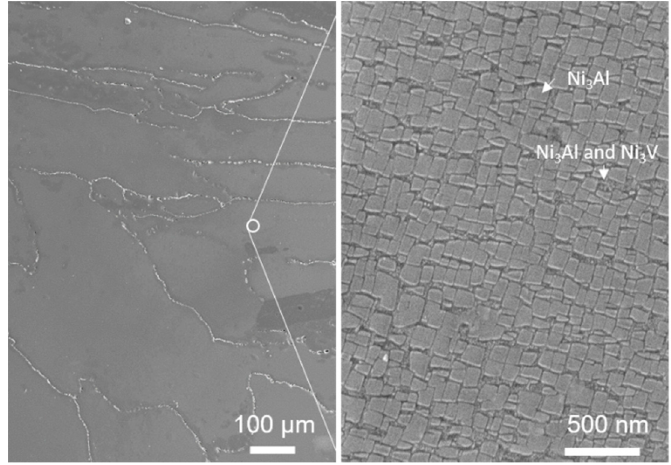
Figure 3. Field emission scanning electron microscopy (FESEM) micrograph of the Ni-9 at.% Al-16 at.% V alloy specimen after arc-melting and subsequent annealing at 1050 °C for 24 h.